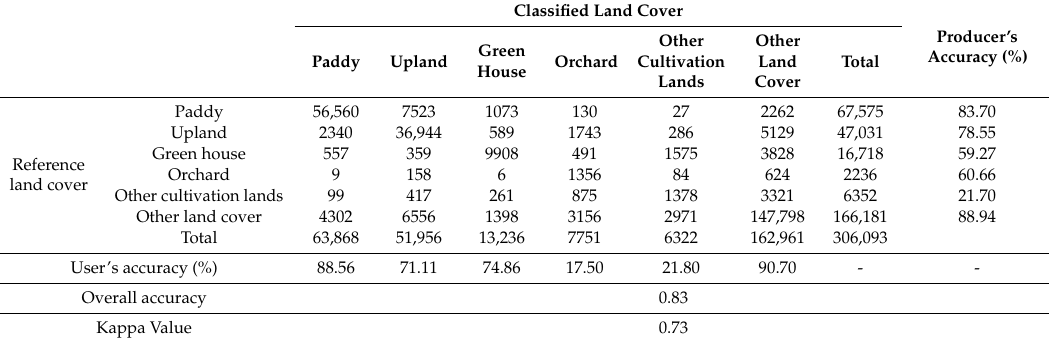
Table 4. Classification results of paddy field, upland, and green house in Daeso-myeon (unit: 1000 pixels). Classified Land